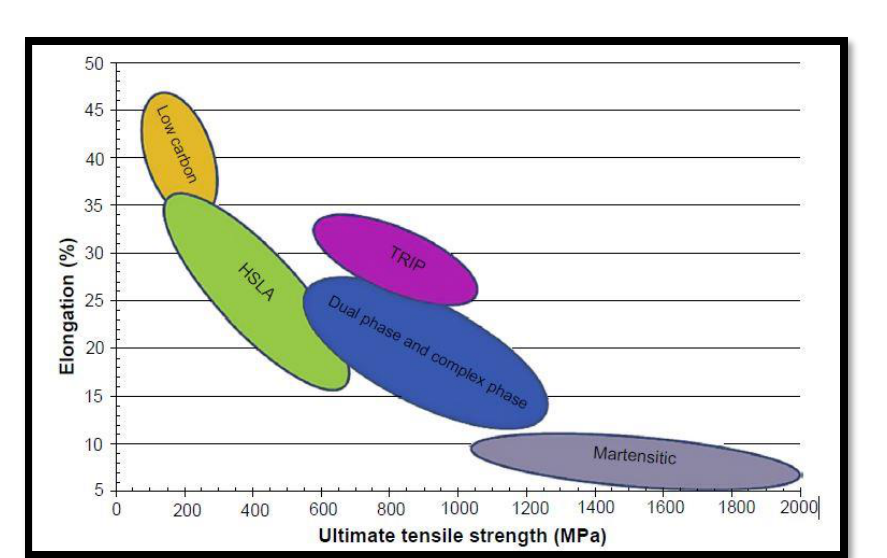
Fig. 1. Strength vs elongation relationship for the first-generation of advanced high-strength steels